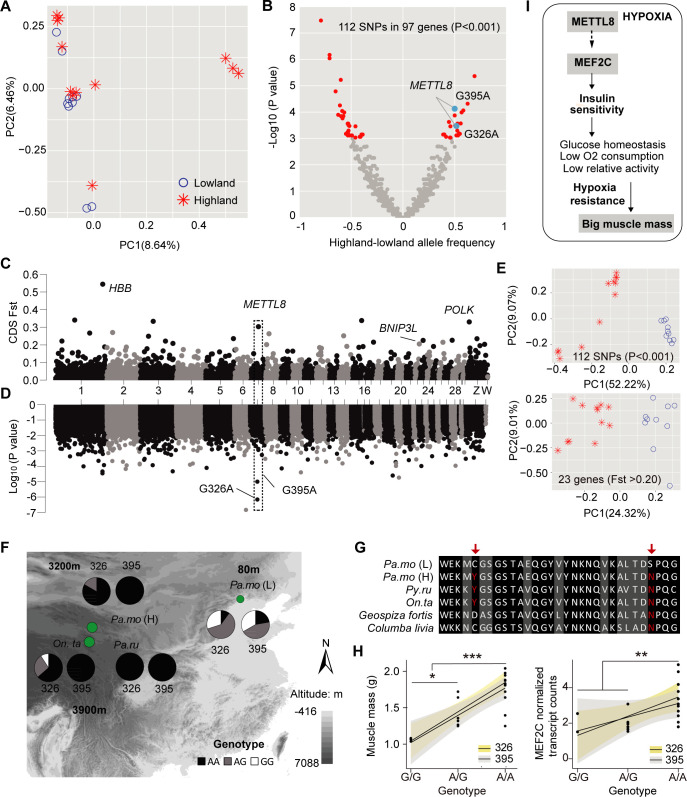
Genetic variation in the METTL8 gene.(A) Principle component analysis of the genetic data (SNPs) for individuals from altitudinal populations. (B) A volcano plot showing allele frequency differences between highland and lowland tree sparrow RNA-seq samples on the x-axis and the–log10 P values on the y-axis. The 112 significant SNPs in 97 genes were labeled in red (n = 10 and 12 for highland and lowland populations). (C) Manhattan plot: Outcome fixation index (Fst) for potential CDS region. (D) Genome-wide association analysis between muscle mass and the genotypes at nearly 120000 SNPs. (E) Principle component analysis of the SNPs of 112 SNPs (P <0.001) and 23 genes with high Fst. (F) Genotypes of the lowlander and highlanders at two METTL8 SNPs. The putatively advantageous homozygote is shown in black, heterozygote was shown in gray, and the non-advantageous homozygote is indicated in white. (G) Amino acid alignment of METTL8 across five species. Putatively advantageous mutations are shown in red. (H) METTL8-A alleles at site 326 and 395 are associated with greater muscle mass (R = 0.88 and 0.83, respectively, n = 19) and MEF2C expression (R = 0.66 and 0.48, respectively, n = 18) in tree sparrow altitudinal populations. (I) Simplified schematic of hypoxia resistance mechanism in high altitude songbirds. Convergent mutations in METTL8 can activate MEF2C transcription, leading to the upregulated expression of SLC2A12 that further promotes insulin sensitivity, and accompanied by EPAS1-controlled muscle development and maintenance.